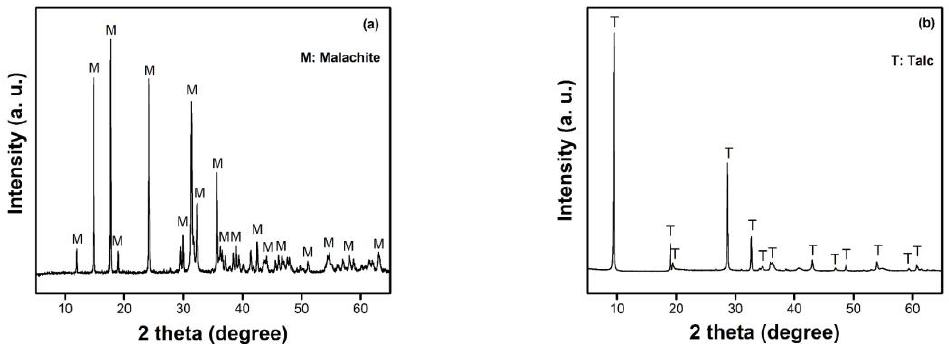
Figure 1. XRD patterns of malachite ( a ) and talc ( b ) samples, respectively. These results are highly similar with those of reported in previous literature [15,16].